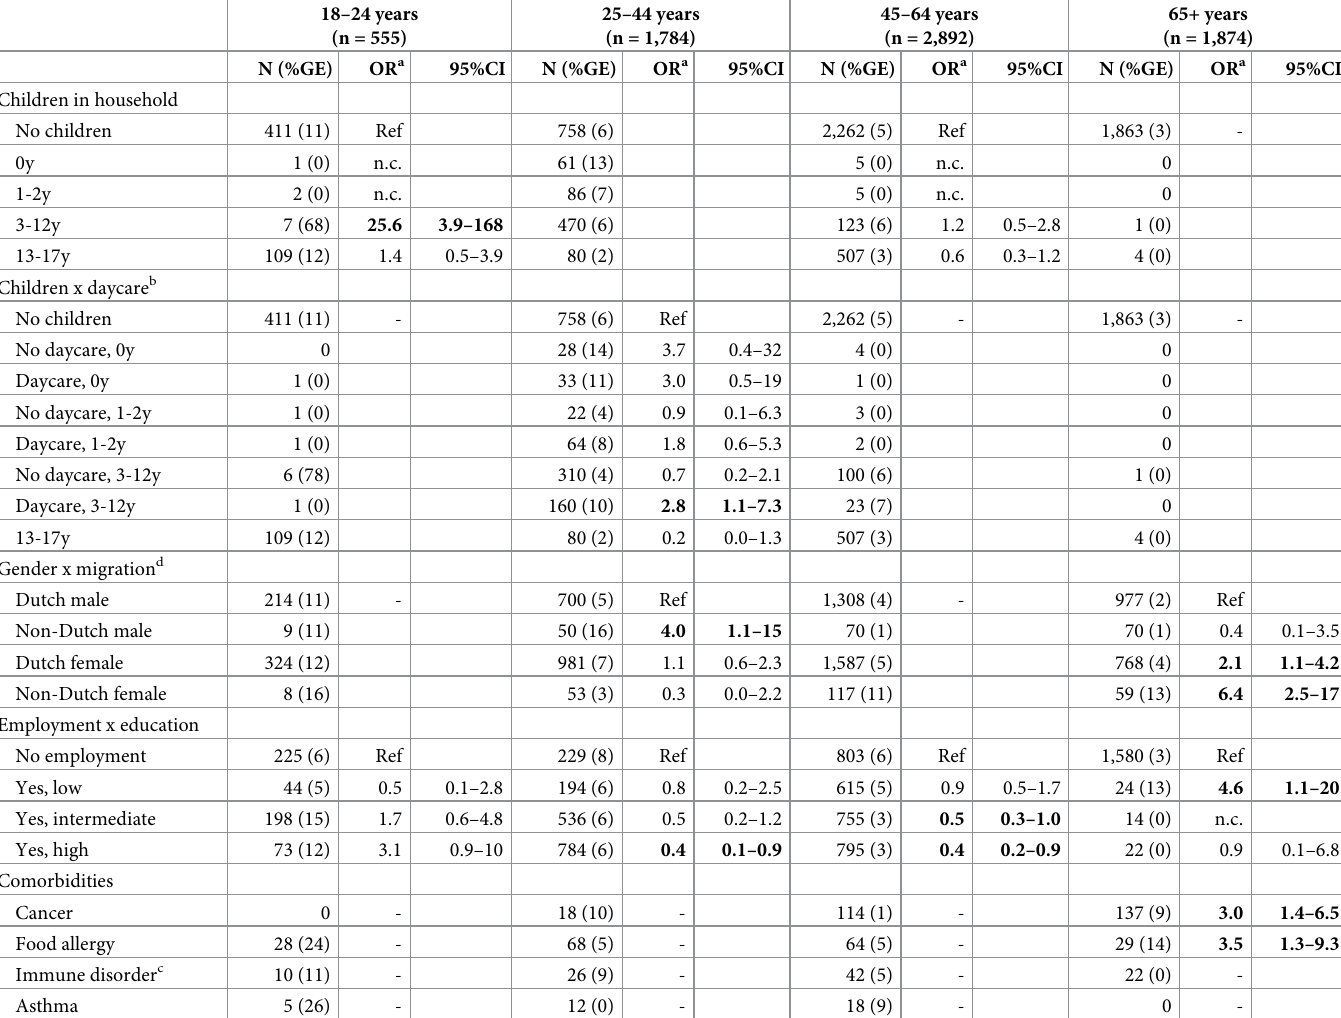
Table 3. Multivariable weighted logistic regression models of factors associated with gastroenteritis in adults, stratified by age